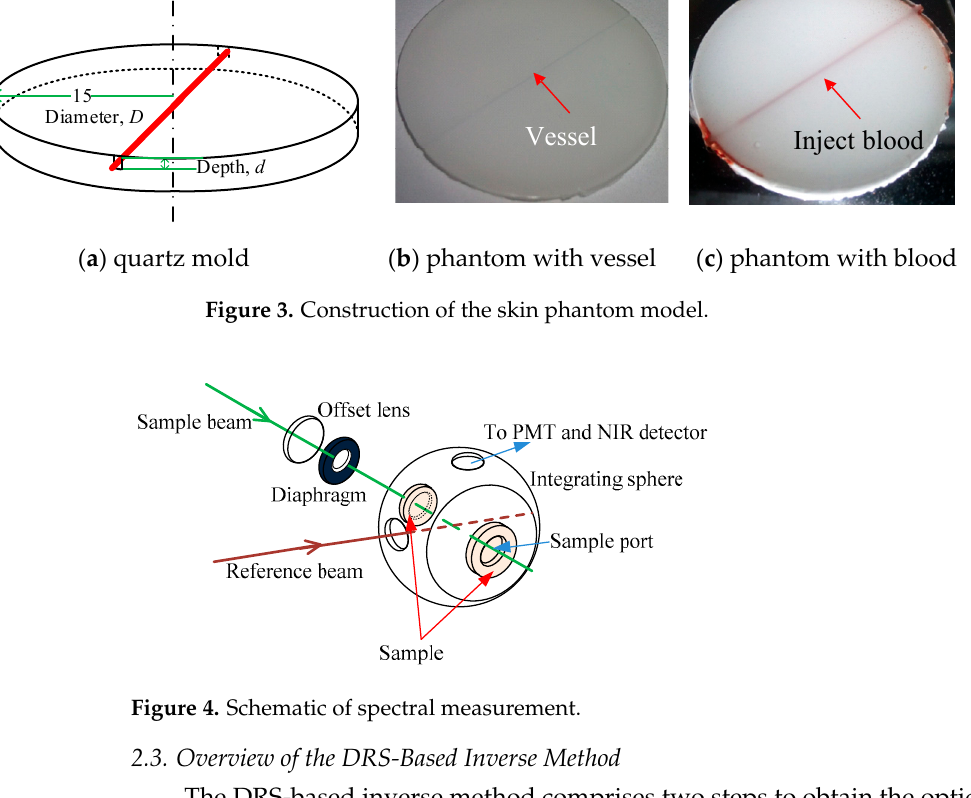
Figure 4. Schematic of spectral measurement.